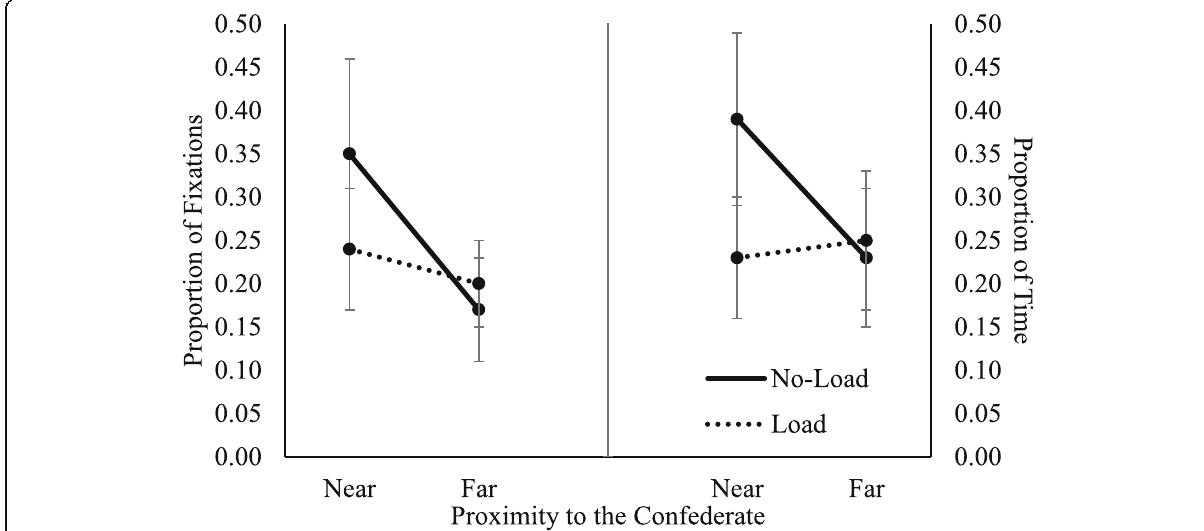
Fig. 4 The mean proportion of fixations (left panel) and time spent on the confederate (right panel) when the confederate was in view for Condition (no-load, load) and Proximity (near, far) in Experiment 3. Bars show 95% confidence intervals